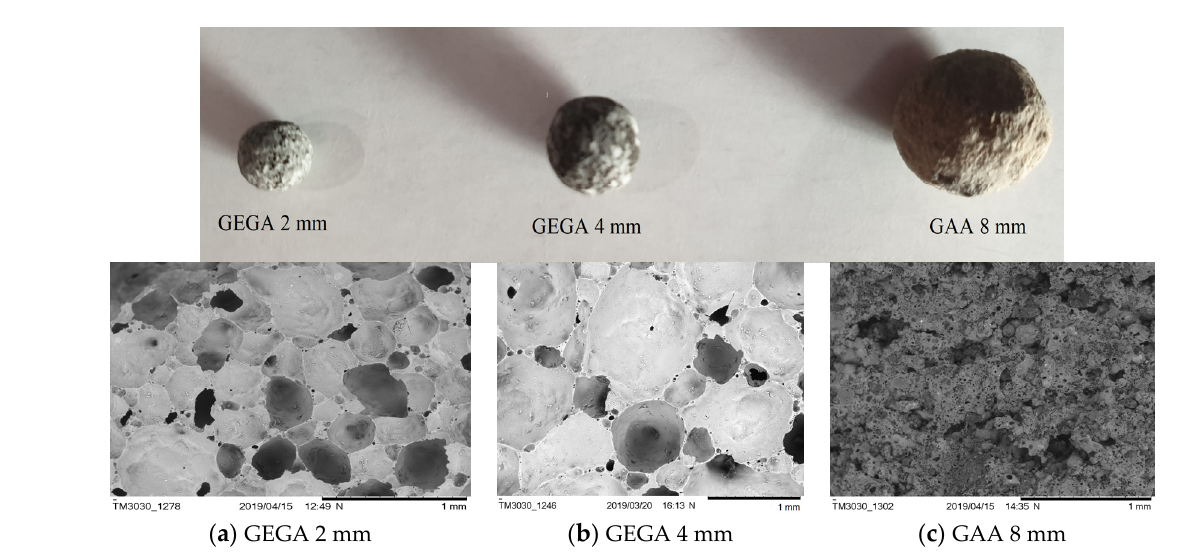
Figure 1. Structure of the LWA used in the tests. Table 1. Physical properties of LWA.